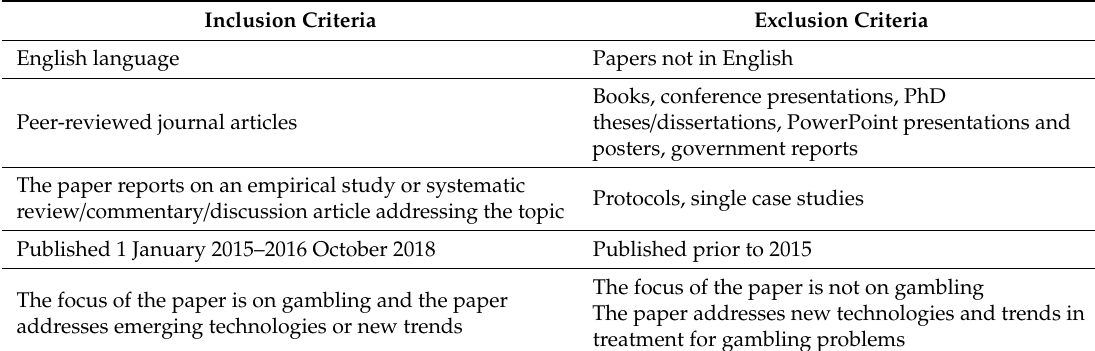
Table 1. Inclusion and exclusion criteria.